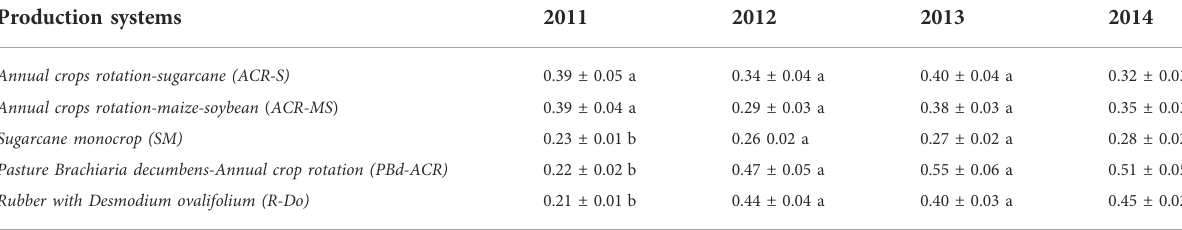
TABLE 5 Soil fertility indicator valued in production systems established in an Oxisol of the Meta High Plains.